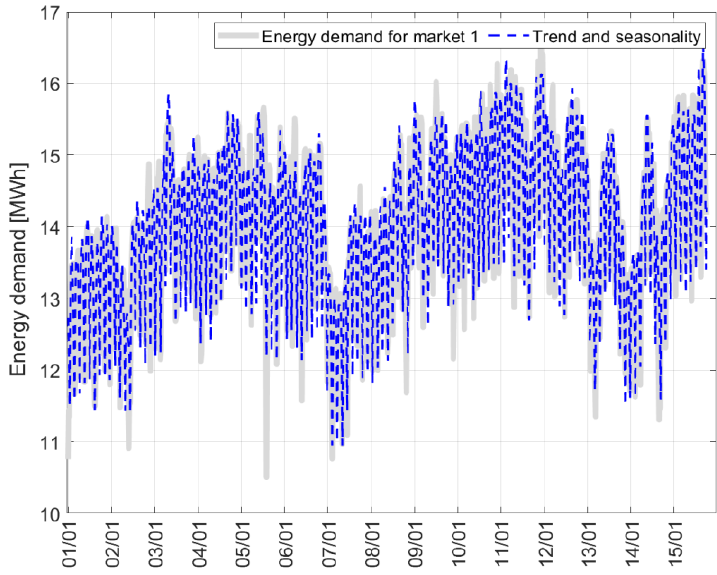
Figure 2. Daily energy demand for Market 1 in the 2016 – 2018 period.